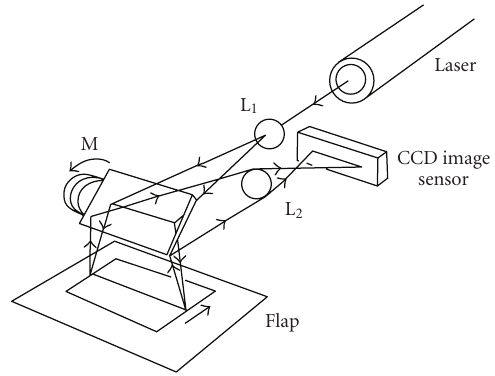
Figure 2: Schematic representation of visualization of two- dimensional blood flow distribution using laser speckle flowgraphy. (L 1 ) Cylindrical lens. (M) Mirror. (L 2 ) Lens